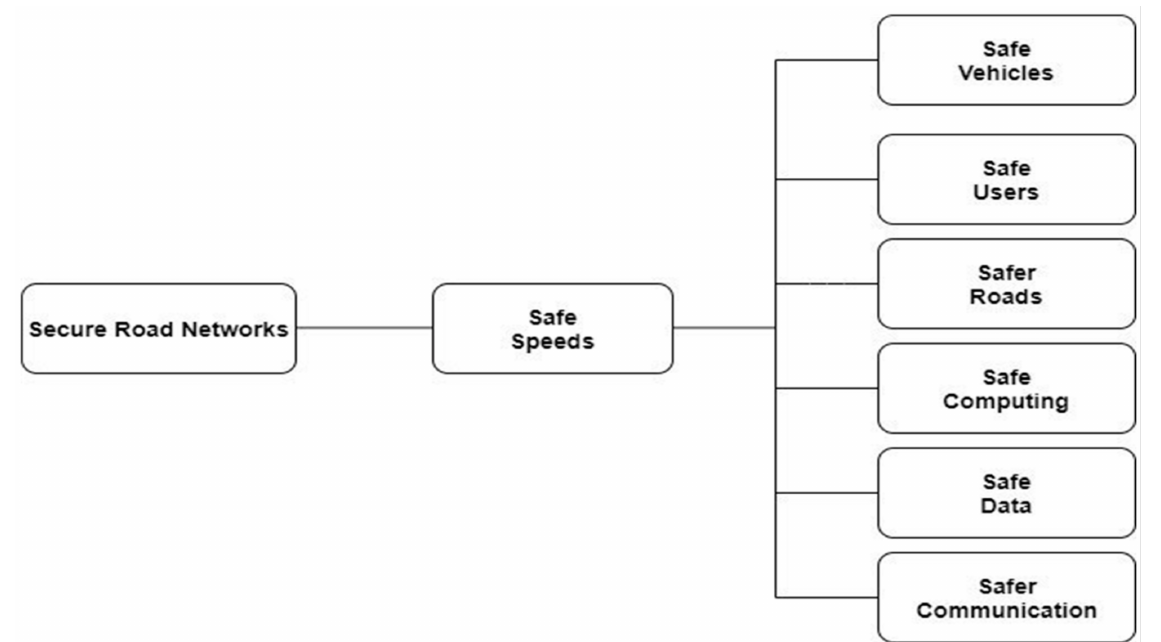
Figure 1. Illustration of a safe system of Interconnected Vehicles